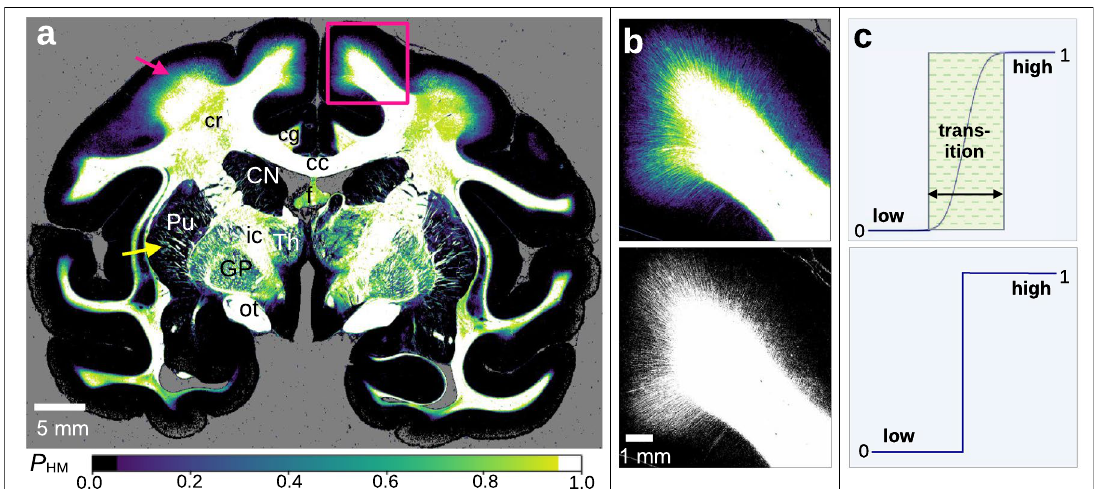
Figure 3. Myelination maps of the coronal vervet brain section. ( a ) HM-probability map of the whole section (computed with 25% sample size and 200 iterations). Regions with P HM < 0.05 are considered to have low myelination (LM-regions, in black), regions with P HM > 0.95 are considered to have high myelination (HM-regions, in white). The transition zone is shown in different colours. The magenta and yellow arrow point to regions with a smooth and sharp transition, respectively. cc = corpus callosum, cg = cingulum, cr = corona radiata, f = fornix, ic = internal capsule, ot = optic tract, CN = caudate nucleus, GP = globus pallidus, Pu = putamen, Th = thalamus. ( b ) Enlarged view of the region marked by the magenta rectangle in ( a ). The top image shows the HM-probability map, the bottom image shows a sharp separation between HM/LM-regions without any transition zone. ( c ) Sketch of the functions used to describe the transition zone between HM/LM-regions. In the HM-probability map, a sigmoid function is used to describe the transition zone (top), the width depends on the computed mean of the threshold parameters, cf. Fig. 2c. The bottom figure illustrates the binary classification. LM = 0, HM =